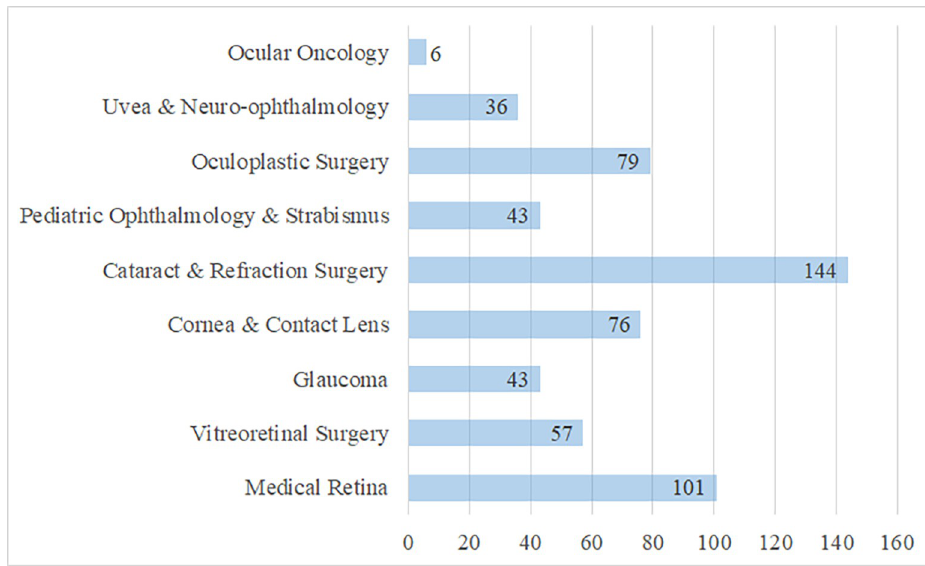
Fig 1. Distribution of the participants according to their ophthalmological interests.